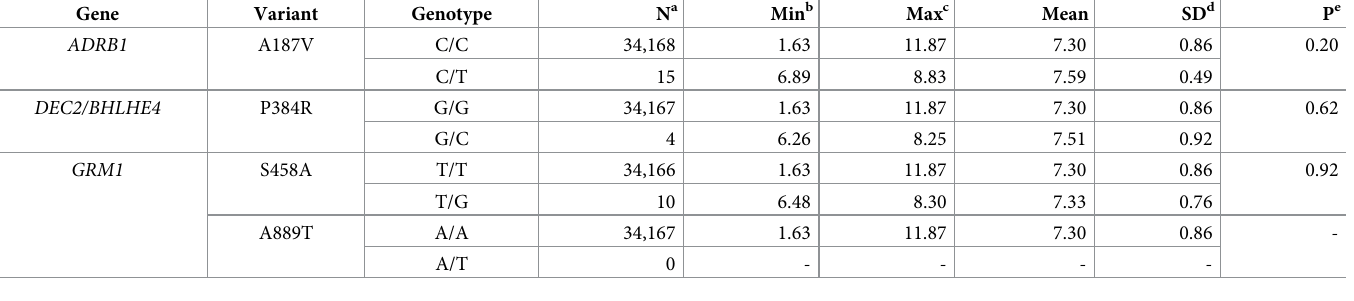
standard deviation e t-test P -value